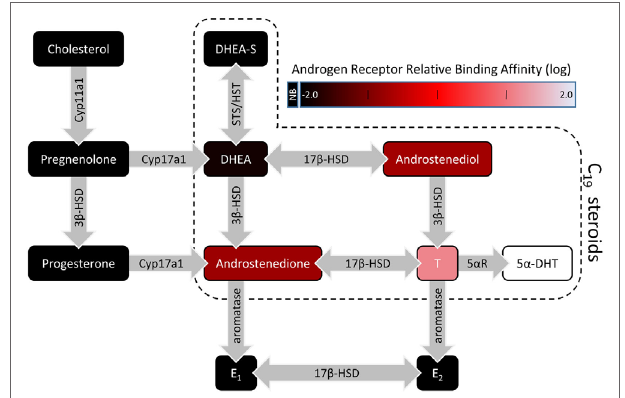
FiGURe 1 | A simplified illustration of the steroidogenic pathway with a focus on C 19 steroids. For C 19 steroids, fill color represents the relative binding affinity to the androgen receptor (4–6). Steroidogenic enzymes are represented by the gray arrows. Abbreviations: 3 β ­HSD, 3 β ­hydroxysteroid dehydrogenase/ isomerase; 5 α R, 5 α ­reductase; 5 α ­DHT, 5 α ­dihydrotestosterone; 17 β ­HSD, 17 β ­hydroxysteroid dehydrogenase; DHEA, dehydroepiandrosterone; DHEA­S, dehydroepiandrosterone sulfate; E 1 , estrone; E 2 , 17 β ­estradiol; HST, hydroxysteroid sulfotransferase; STS, steroid sulfatase; NB, no